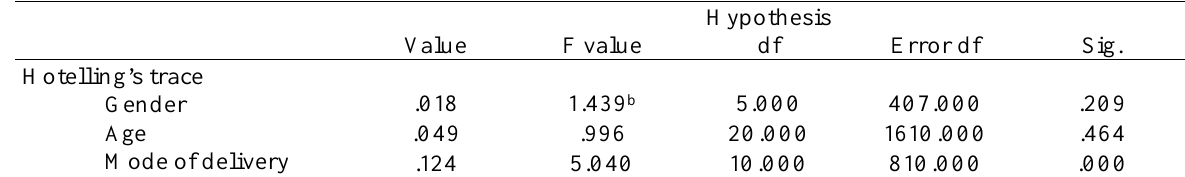
F-tests: Gender, Age, and Mode of Delivery on MOOCs Readiness Dimensions